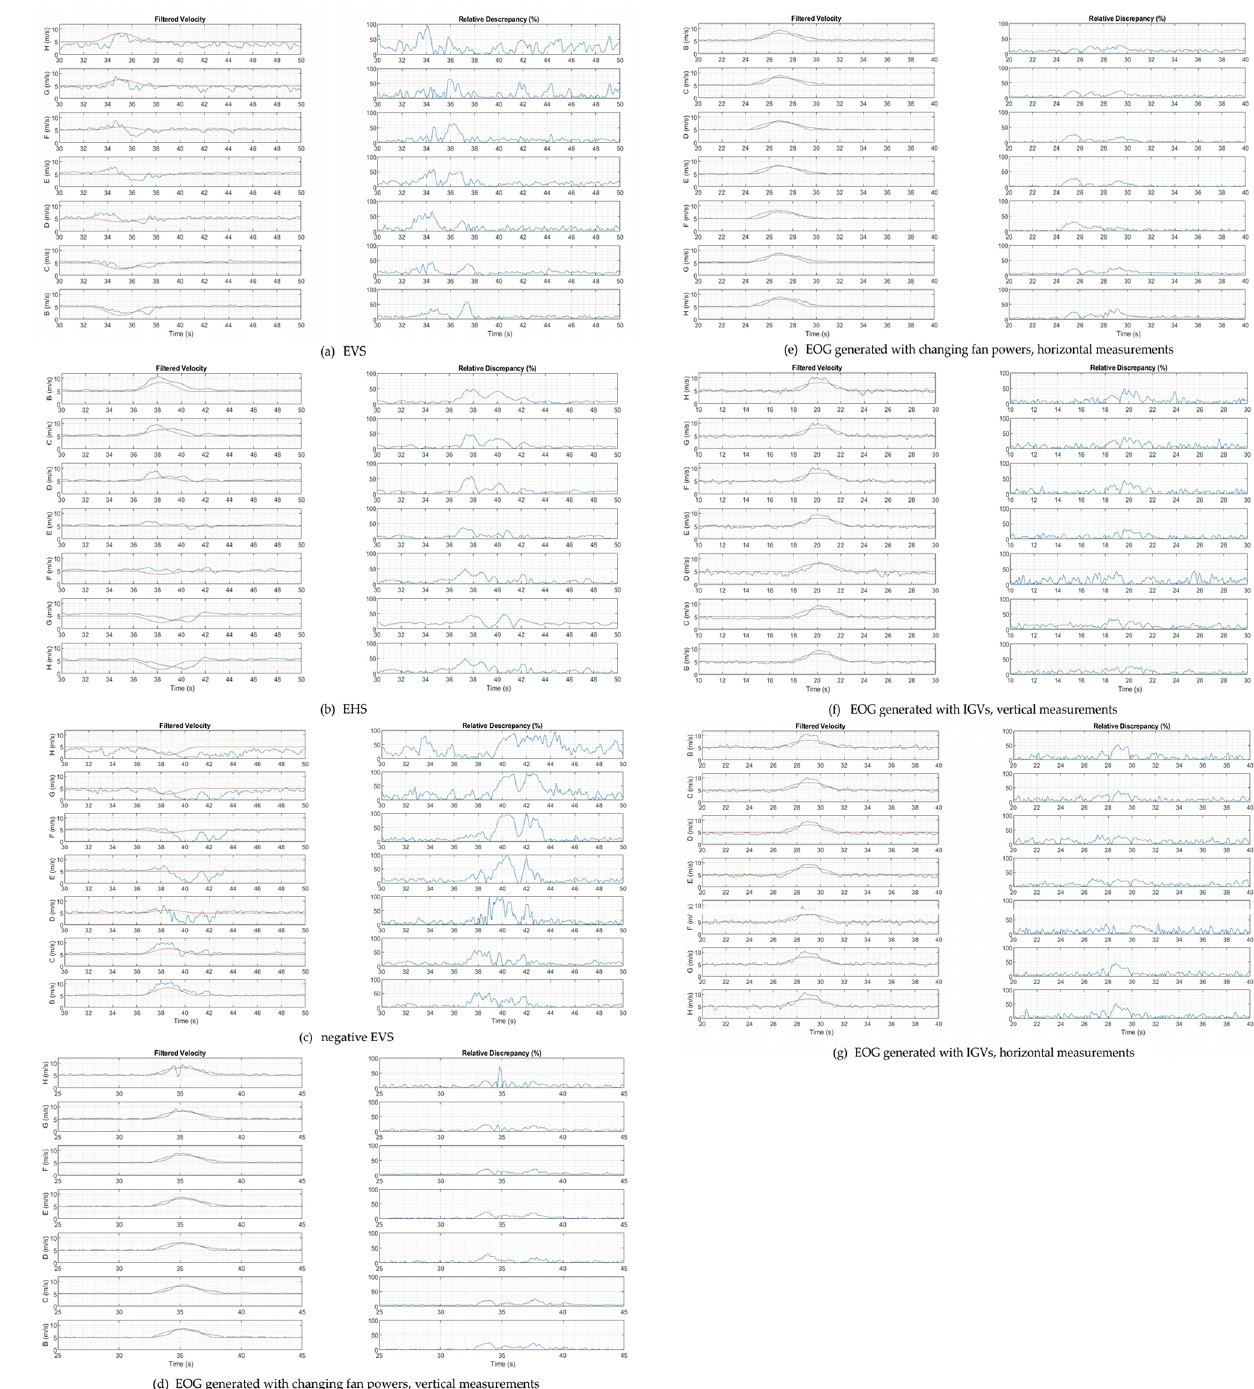
Figure 12. Filtered velocity time history at each probe (with the layout presented in Fig. 6) as a blue solid line compared with prescribed extreme event velocity as the orange solid line (left columns) and time history of relative instantaneous velocity discrepancy normalized by average velocity (right